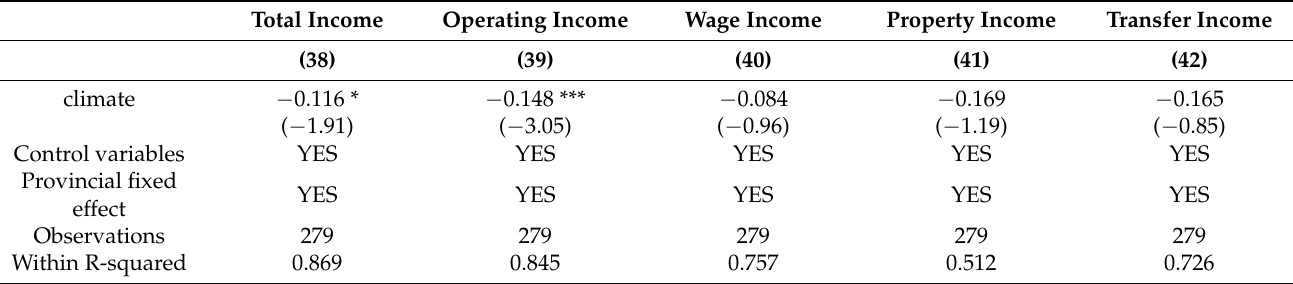
Table 9. Climate variation and rural residents’